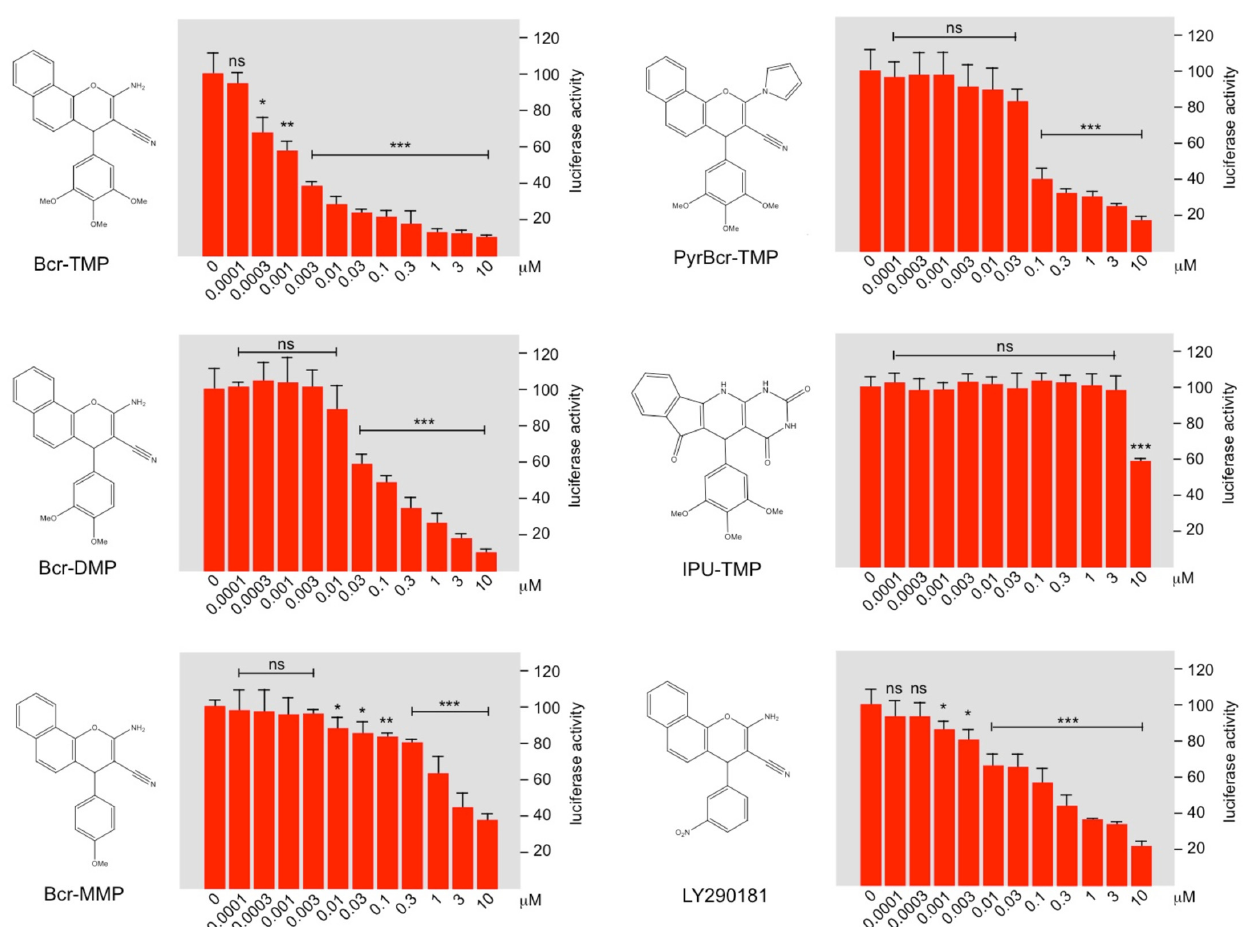
Figure 6. Structure–activity analysis of Bcr-TMP-related compounds. The columns in each panel show the relative luciferase activity in HEKT cells transfected with reporter plasmid pGL4-5xMRE(GG)-Myc and expression vector for MYB-2KR, treated for 16 h with the indicated concentrations of the compounds shown to the left. Asterisks indicate statistical significance (* p < 0.05; ** p < 0.01, *** p < 0.001, Student’s t -test).